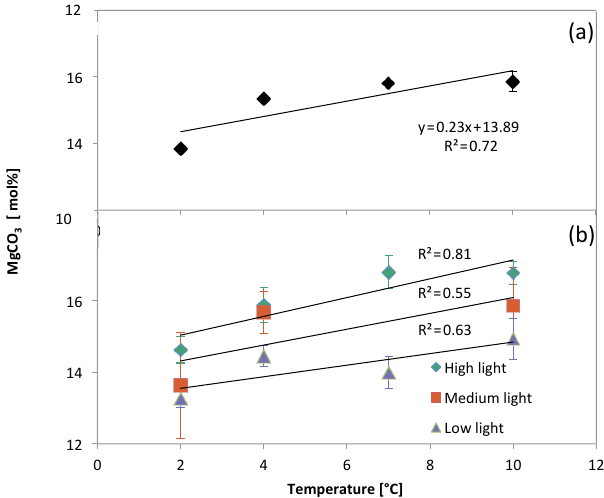
Figure 12. (a) Electron-microprobe-derived MgCO 3 concentra- tions ( ± standard error) of each temperature treatment group after averaging all light levels. (b) Electron-microprobe-derived MgCO 3 concentrations ( ± standard error) of each temperature/light treat- ment